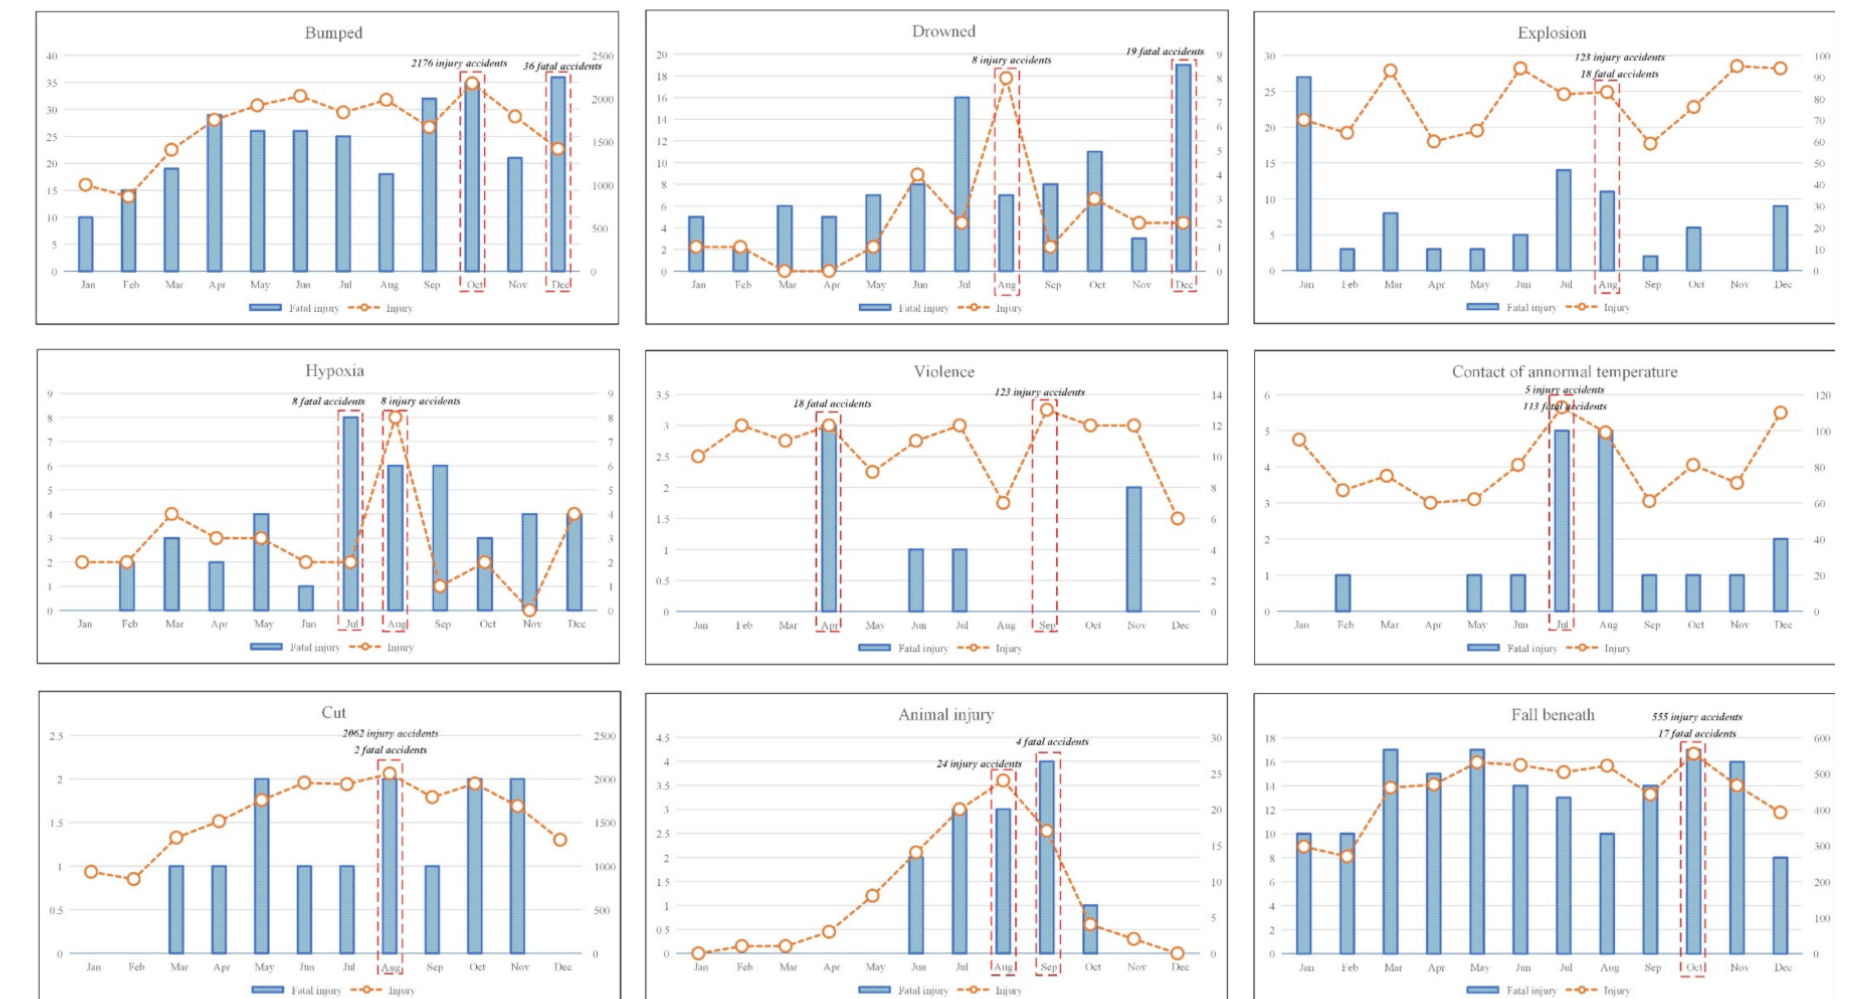
Figure 5. Graph of monthly injury and fatal accidents in terms of accident